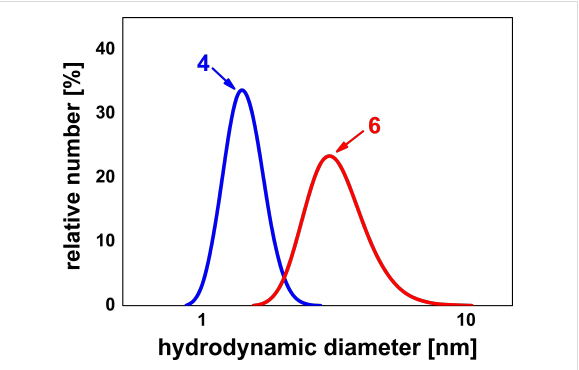
The dilution of the hydroxy groups in the obtained product 6 was proven by IR spectroscopy by the nearly complete disap- pearance of the OH-related absorption band at 3370 cm − 1 .